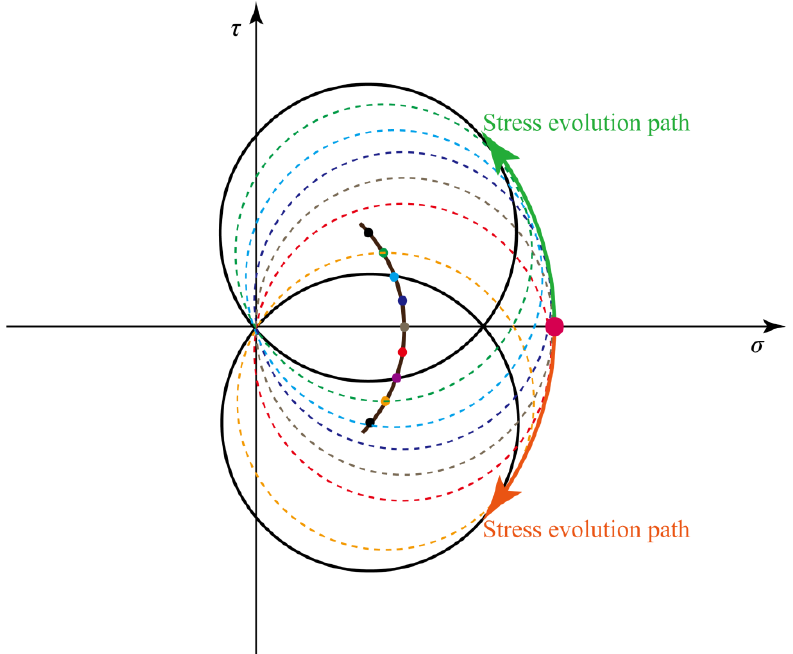
Figure 6. Stress path controlled by dip angle.